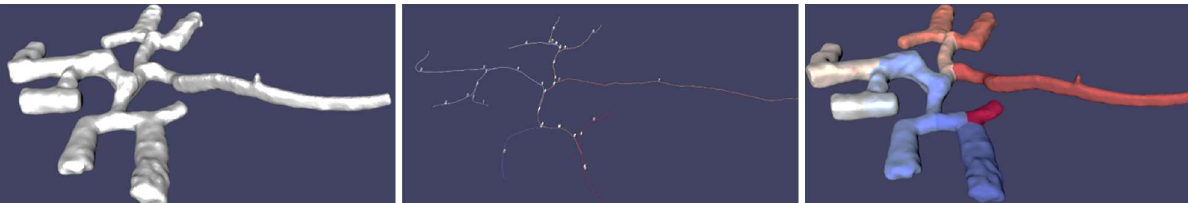
Figure 7 . Simplified model of the Monte Celva underground spaces (left), and the 3D skeleton (centre) and space segmentation (right) obtained from the VMTK algorithm.